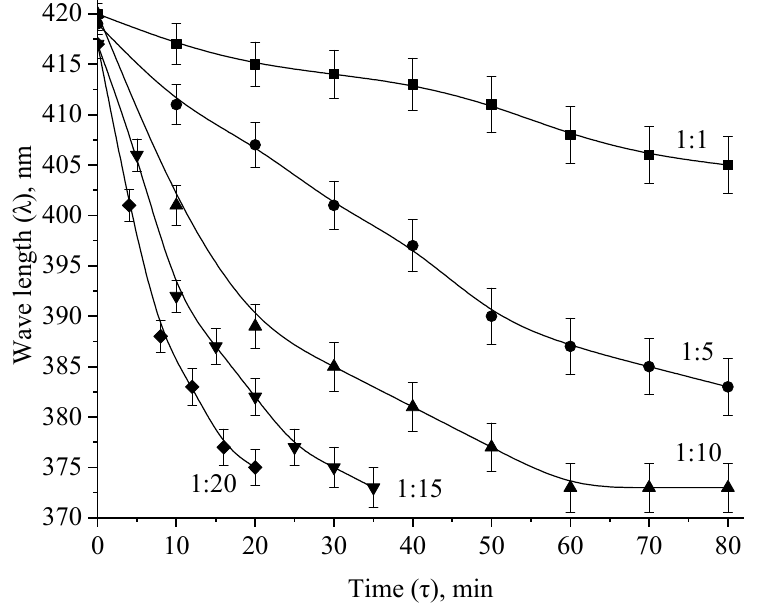
Figure 16. Kinetic dependences of changes in the position of the absorption band of the plasmon resonance of Ag NPs during oxidation with H 2 O 2.